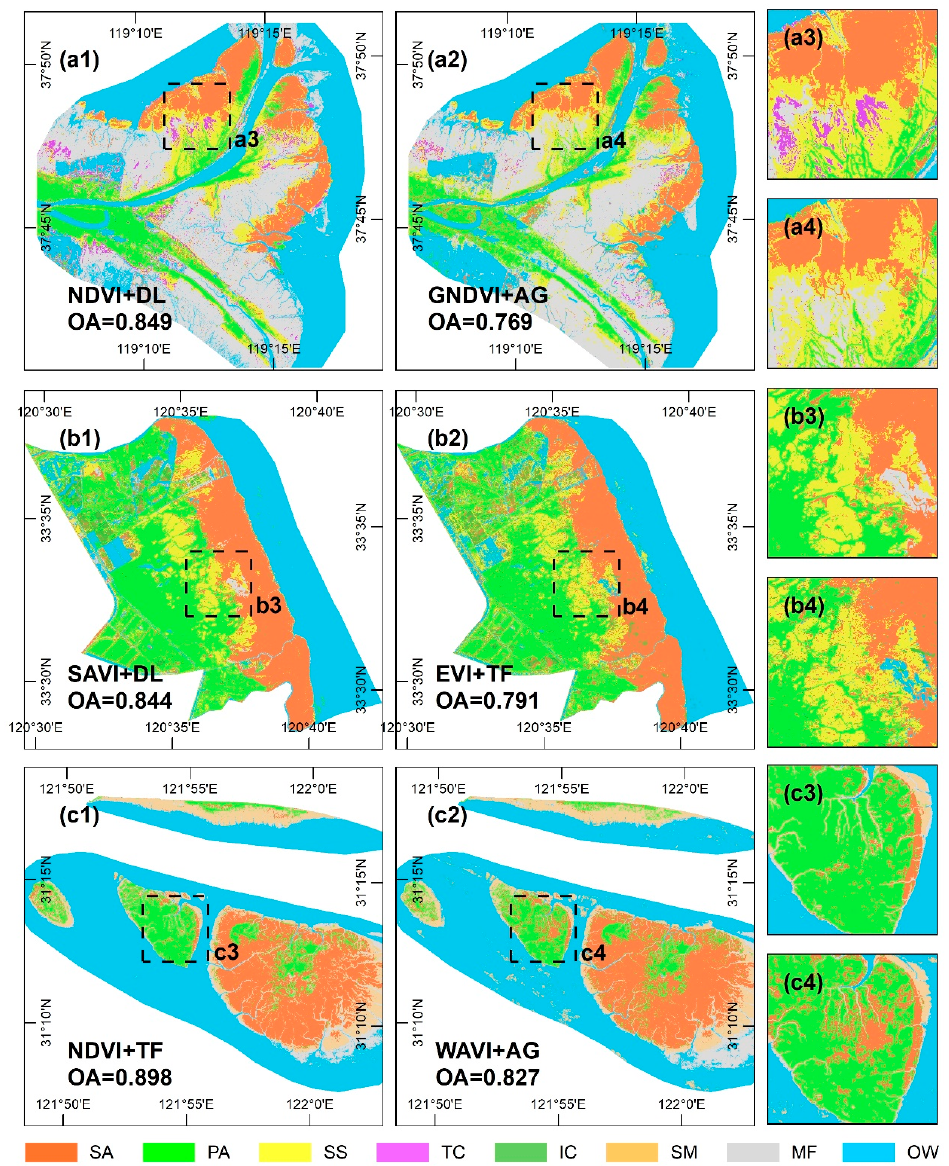
Figure 8. Classification maps for salt marsh vegetation corresponding to different VI time series-based curve fitting models. ( a1 – c1 ) Classification maps corresponding to the models with high separability, ( a2 – c2 ) classification maps corresponding to the models with low separability; ( a3 – c3 ) and ( a4 – c4 )